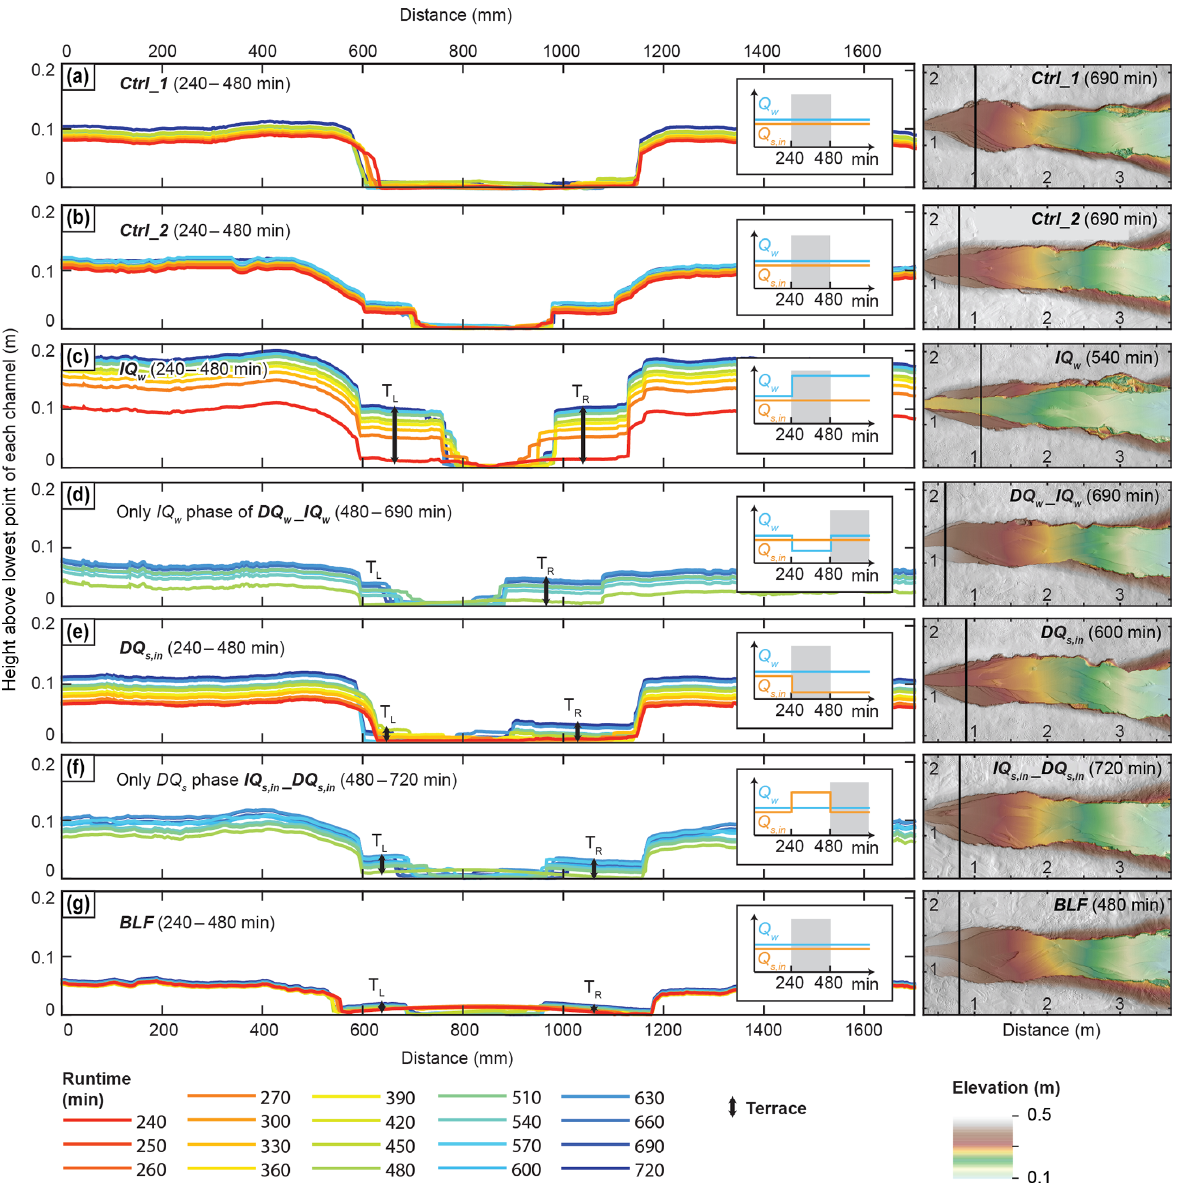
Figure 4. Evolution of cross sections in the upper part of the channel (left panel). In each cross section, the lowest point is set equal to zero to track incision. The color scheme represents absolute experimental runtime, beginning after the spin-up phase (i.e., 240min). For better comparison, we plot a maximum of 240min for all experiments, despite longer recordings for some of the runs. Exact locations of cross sections are indicated by the black lines in the DEMs displaying the last scan of each experiment (right panel). Cross sections have been chosen at the terrace midpoints and thus vary slightly between the experiments. The times given in parentheses are the absolute experiment